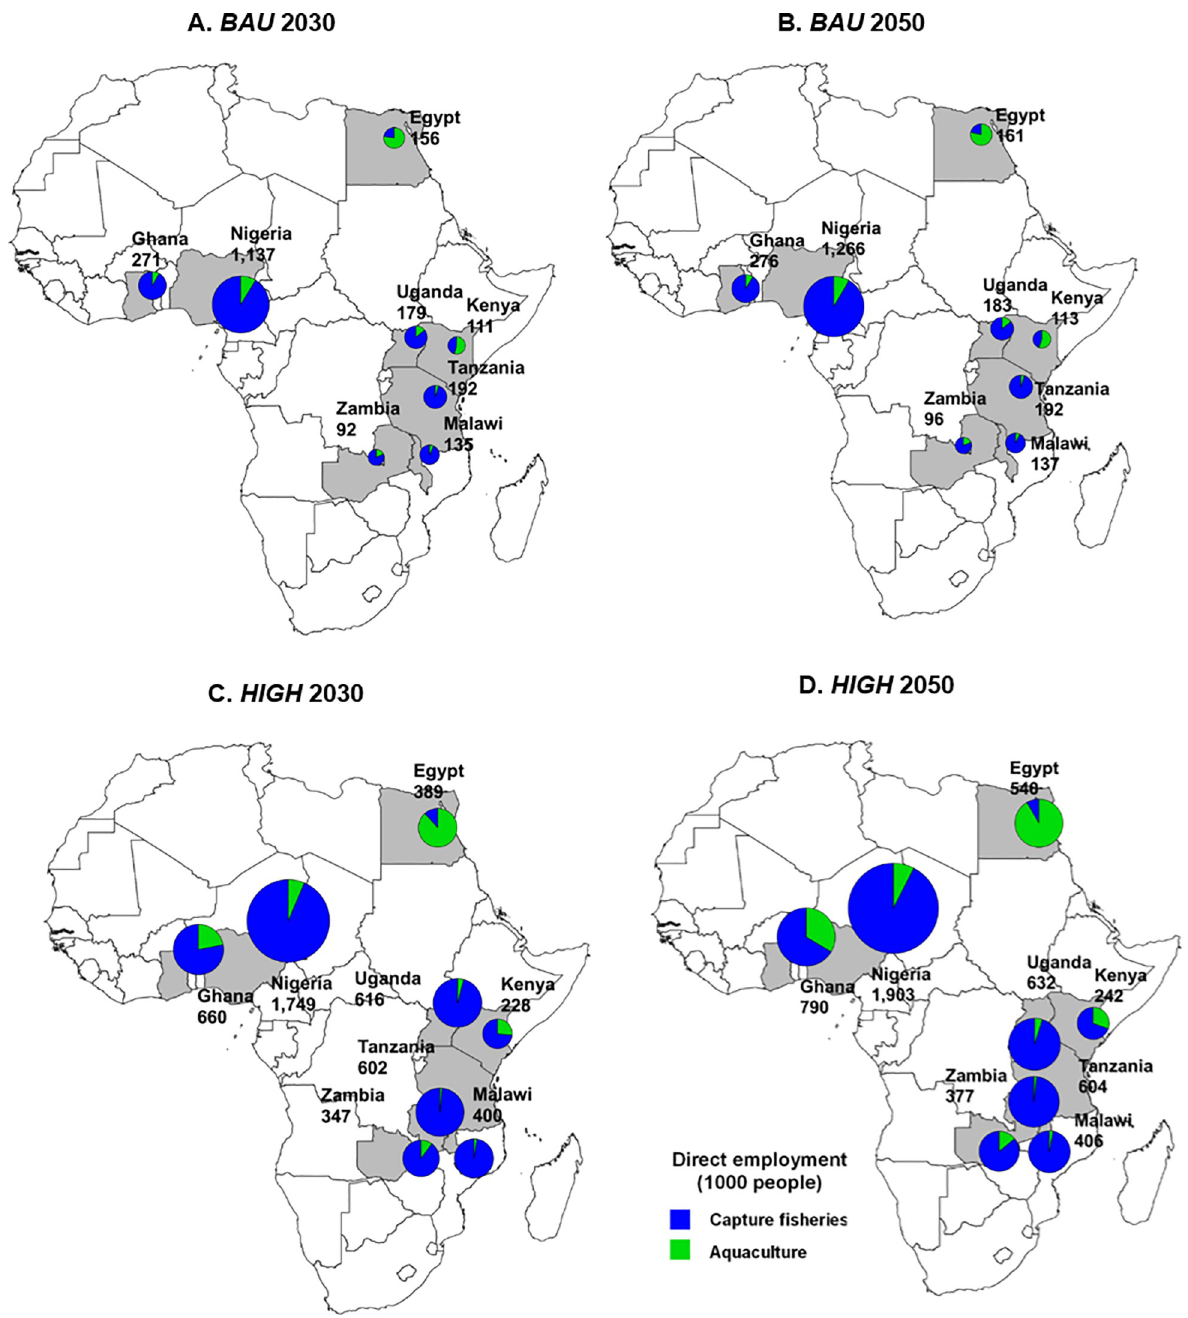
Fig 2. Direct employment of capture fisheries and aquaculture under BAU scenario in 2030 (A), BAU scenario in 2050 (B), HIGH scenario in 2030 (C), and HIGH scenario in 2050 (D).